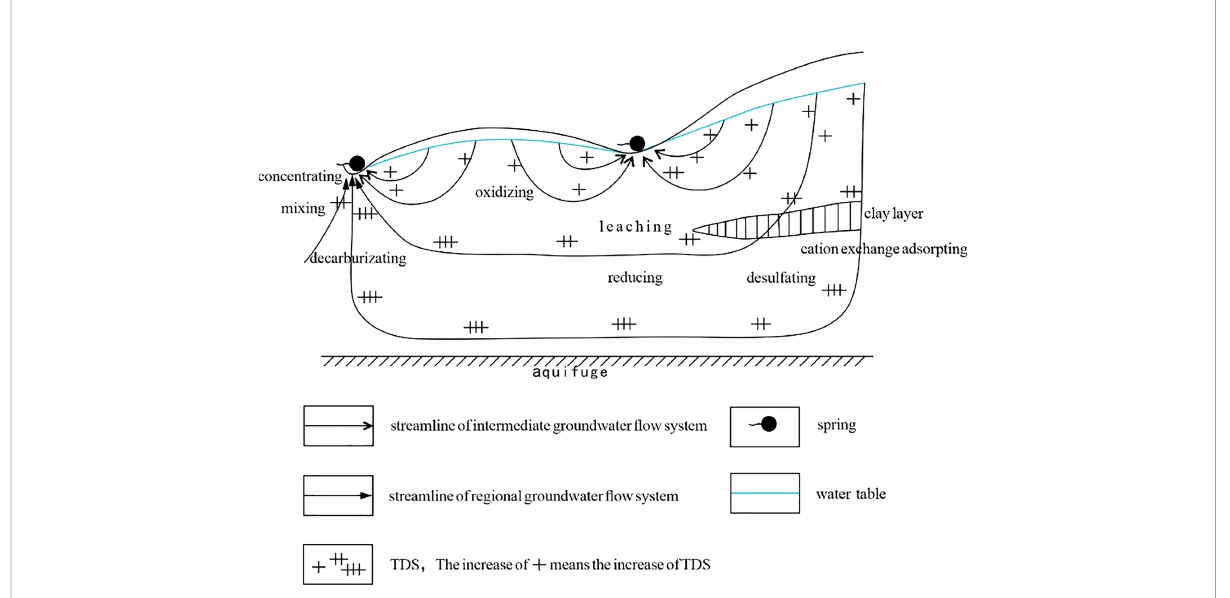
FIGURE 4 An ideal model for hydrochemical evolution of groundwater fl ow system (modi fi ed after Wang, 1995).